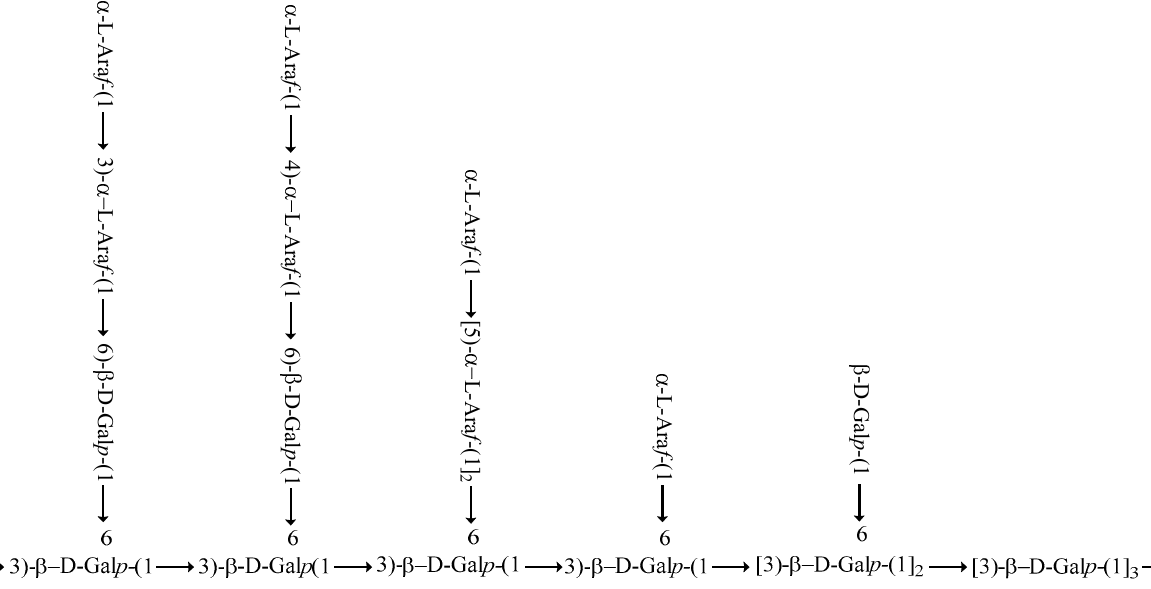
Figure 6. Possible structure of LBP-3.